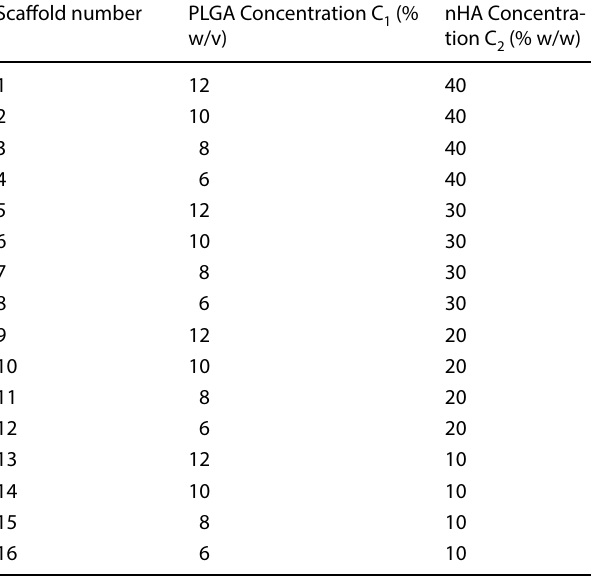
Table 1 Composition of the scaffolds prepared for this study Scaffold